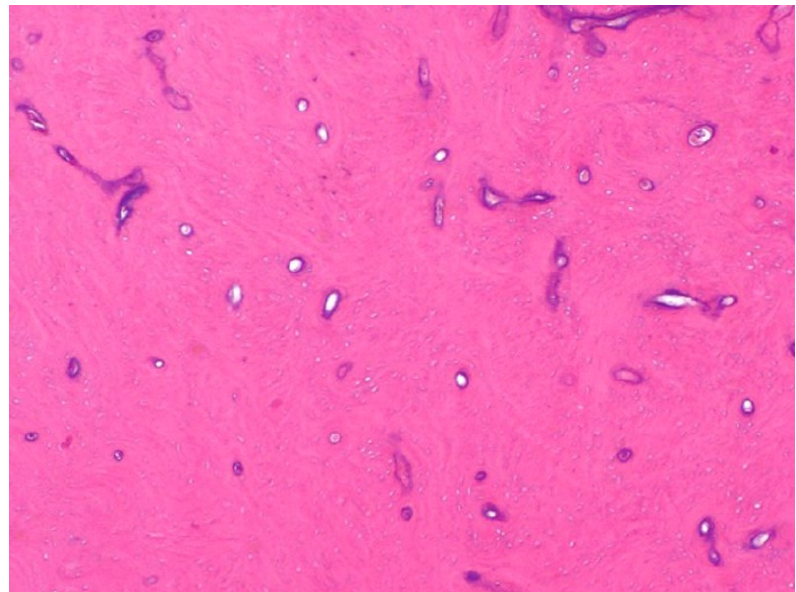
Figure 3. Microscopic view (hematoxylin–eosin staining ×40) of a maxillary sinus osteoma. The following features are observed: multiple areas of compact lamellar bone deposition and proliferation of irregular trabeculae, with few osteons and minimal marrow spaces.